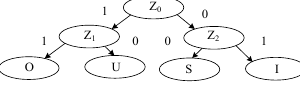
Fig. 1. A dichotomizing fragment of a tree of processes of search of refusals in the magnetometer, the satellite navigation system, and optical devices: O – refusal in optical system, U – uncertain refusal, S – the failure of the satellite navigation system, I – diagnostics of